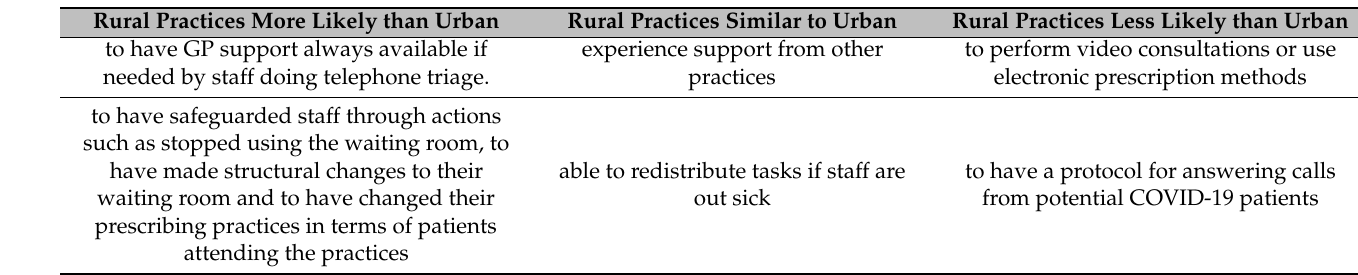
Table 4. Key findings of this paper at a